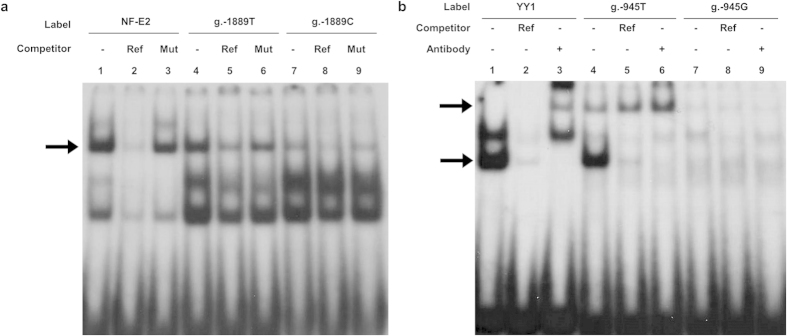
Identification of interaction between transcription factors and genetic variants on OCTN2 promoter through EMSA.(a) 32P-labeled oligonucleotides (lanes 1–3, NF-E2 consensus; lanes 4–6, g.-1889T reference; lanes 7–9, g.-1889C variant) were incubated with 10 μg of nuclear protein extracts obtained from HCT-116. Competition assay was performed using 100-fold molar excess of unlabeled NF-E2 consensus oligonucleotides (lanes 2, 5, and 8) or unlabeled mutant NF-E2 oligonucleotides (lanes 3, 6, and 9). The arrow indicates the band of the DNA-protein complex. (b) 32P-labeled oligonucleotides (lanes 1–3, YY1 consensus; lanes 4–6, g.-945T reference; lanes 7–9, g.-945G variant) were incubated with 10 μg of nuclear protein extracts. Competition assay was performed using 100-fold (lanes 2, 5, and 8) molar excess of unlabeled YY1 consensus oligonucleotides. Supershift experiments were performed with 2 μg of the antibody against YY1 (lanes 3, 6, and 9). The lower arrow indicates the position of the DNA-protein complex and upper arrow indicates supershift band that formed the complex including labeled probe, YY1 protein, and anti-YY1 antibody (lanes 3 and 6). None of the shift or supershift bands with g.-945G variant were shown in this experiment due to weak binding affinity with the sequence.